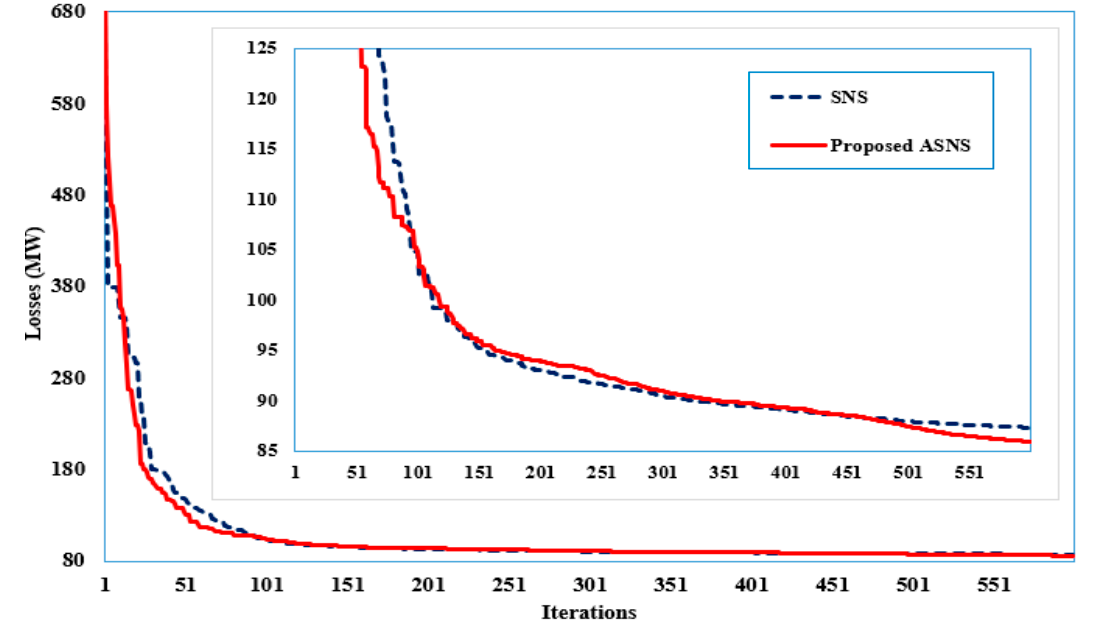
Figure 12. Convergence features of the proposed ASNS and SNS for Case 1 of the large-scale IEEE 118-bus grid. Table 10. Comparative results for Case 1 of the IEEE 118-bus grid.